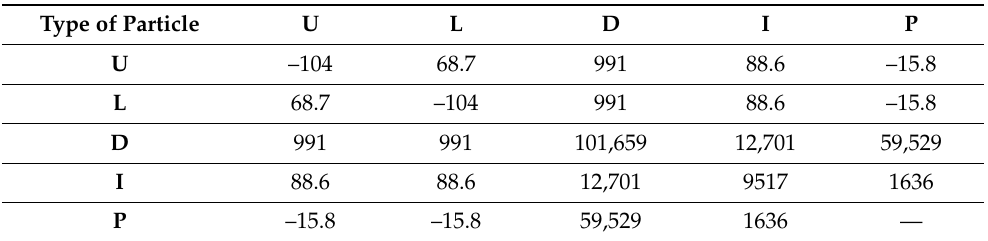
Table 1. Values of integrals β 1,AB for different types of interacting particles. The values are in the units of nm 2 .